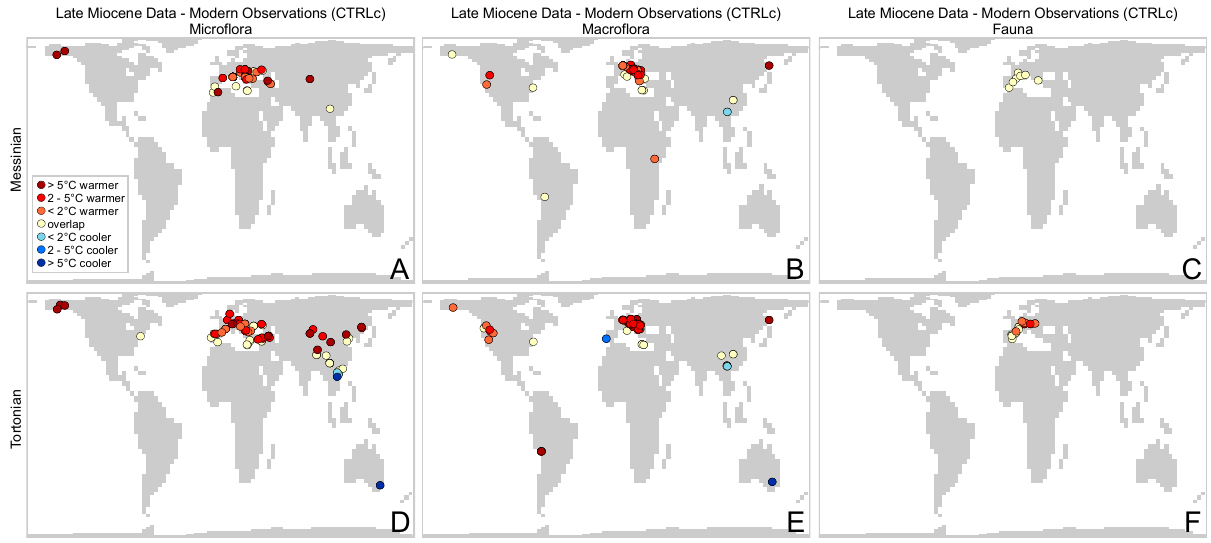
Fig. 7. Results from the model–data comparison for mean annual temperature, late Miocene data – modern potential natural climate estimates.